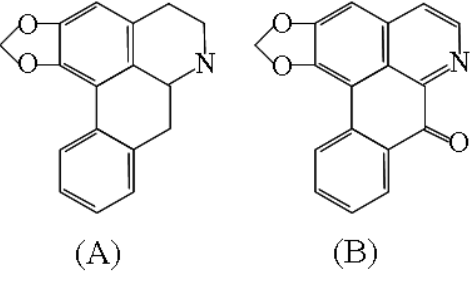
Figure 1 . Chemical structures of anonaine ( A ) and liriodenine ( B